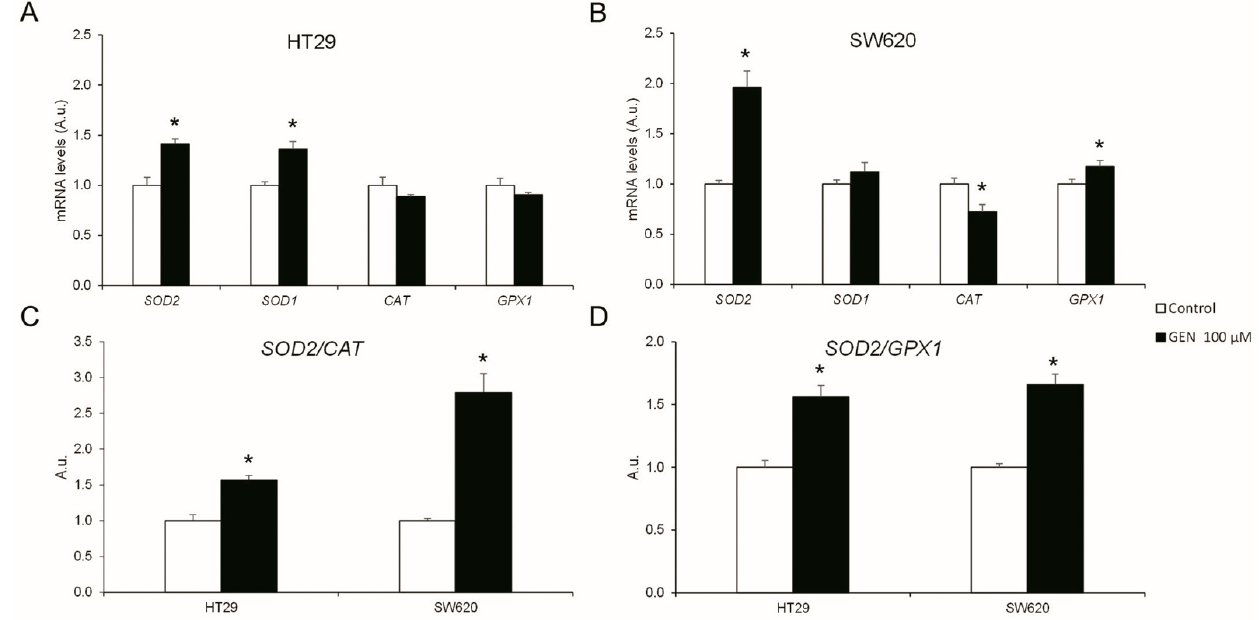
Figure 4. Effects of genistein on antioxidant enzymes’ mRNA expression levels ( SOD2, SOD1, CAT , and GPX1 ) in ( A ) HT29 cells and ( B ) SW620 cells determined by real-time PCR. Effects of genistein on mRNA expression levels ratios of ( C ) SOD2/CAT and ( D ) SOD2/GPX1 genes determined by real-time PCR. The measurements were made with genistein 100 µ M or 0.1% DMSO (control cells) treatment for 48 h. The coordinate values represent mRNA levels (arbitrary units). Values are expressed as mean ± SEM and control values were set at 1.00. GEN, genistein; A.u., arbitrary units. * Significant difference between control cells and genistein-treated cells (Student’s t -test; p < 0.05, n =